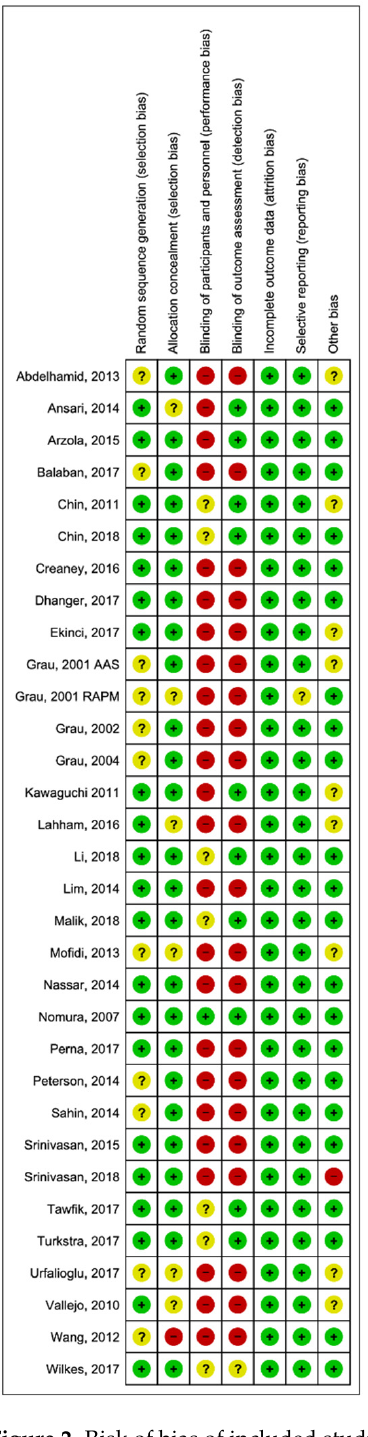
Figure 2. Risk of bias of included studies.